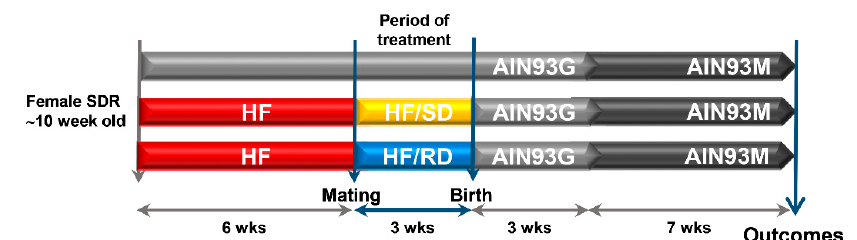
Figure 1. Experimental model. Virgin rats were assigned to one of three experimental groups: reference dams fed a standard rodent diet before mating and throughout pregnancy; dams fed a high-fat diet (HF) six weeks before mating and then an HF diet containing either carbohydrates with a high (HF–RD) or low (HF–SD) digestion rate throughout pregnancy. At delivery, all the animals were fed the standard rodent diet for the remainder of the study (10 weeks). SDR, Sprague-Dawley